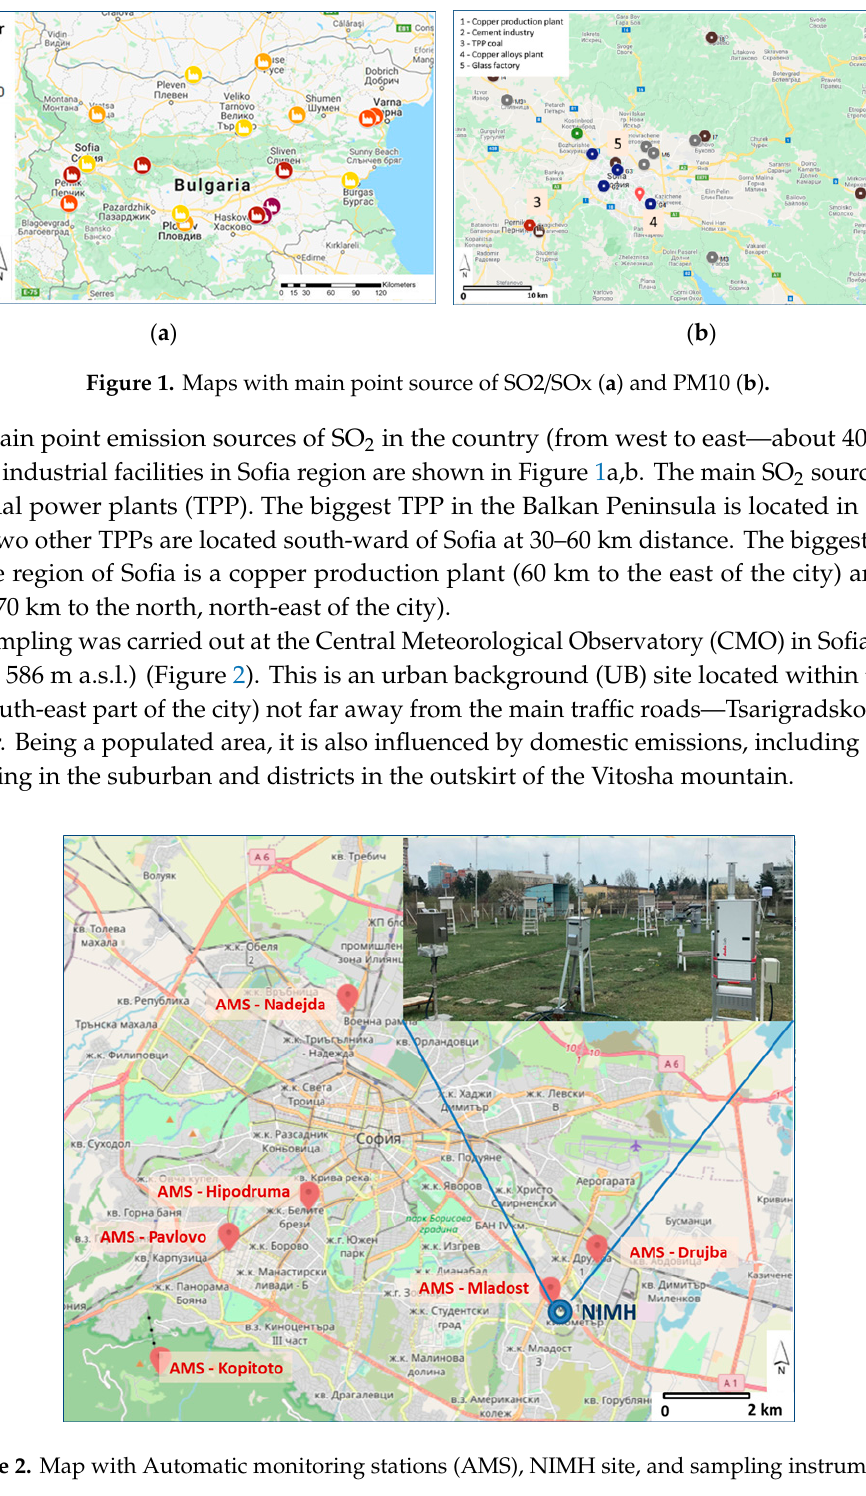
Figure 2. Map with Automatic monitoring stations (AMS), NIMH site, and sampling instruments .